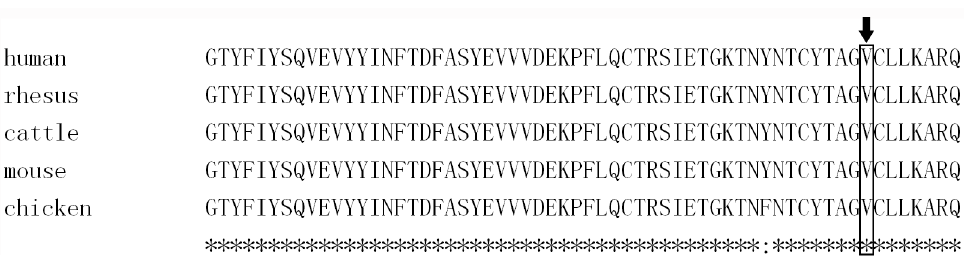
Figure 3. A cross-species alignment of amino acid sequence of Ectodysplasin A (EDA) showed that p.Val351 was conserved.